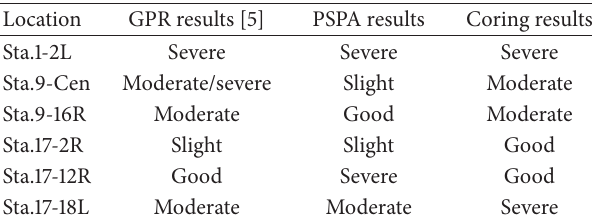
Table 1: Summary of results for GPR, PSPA, and